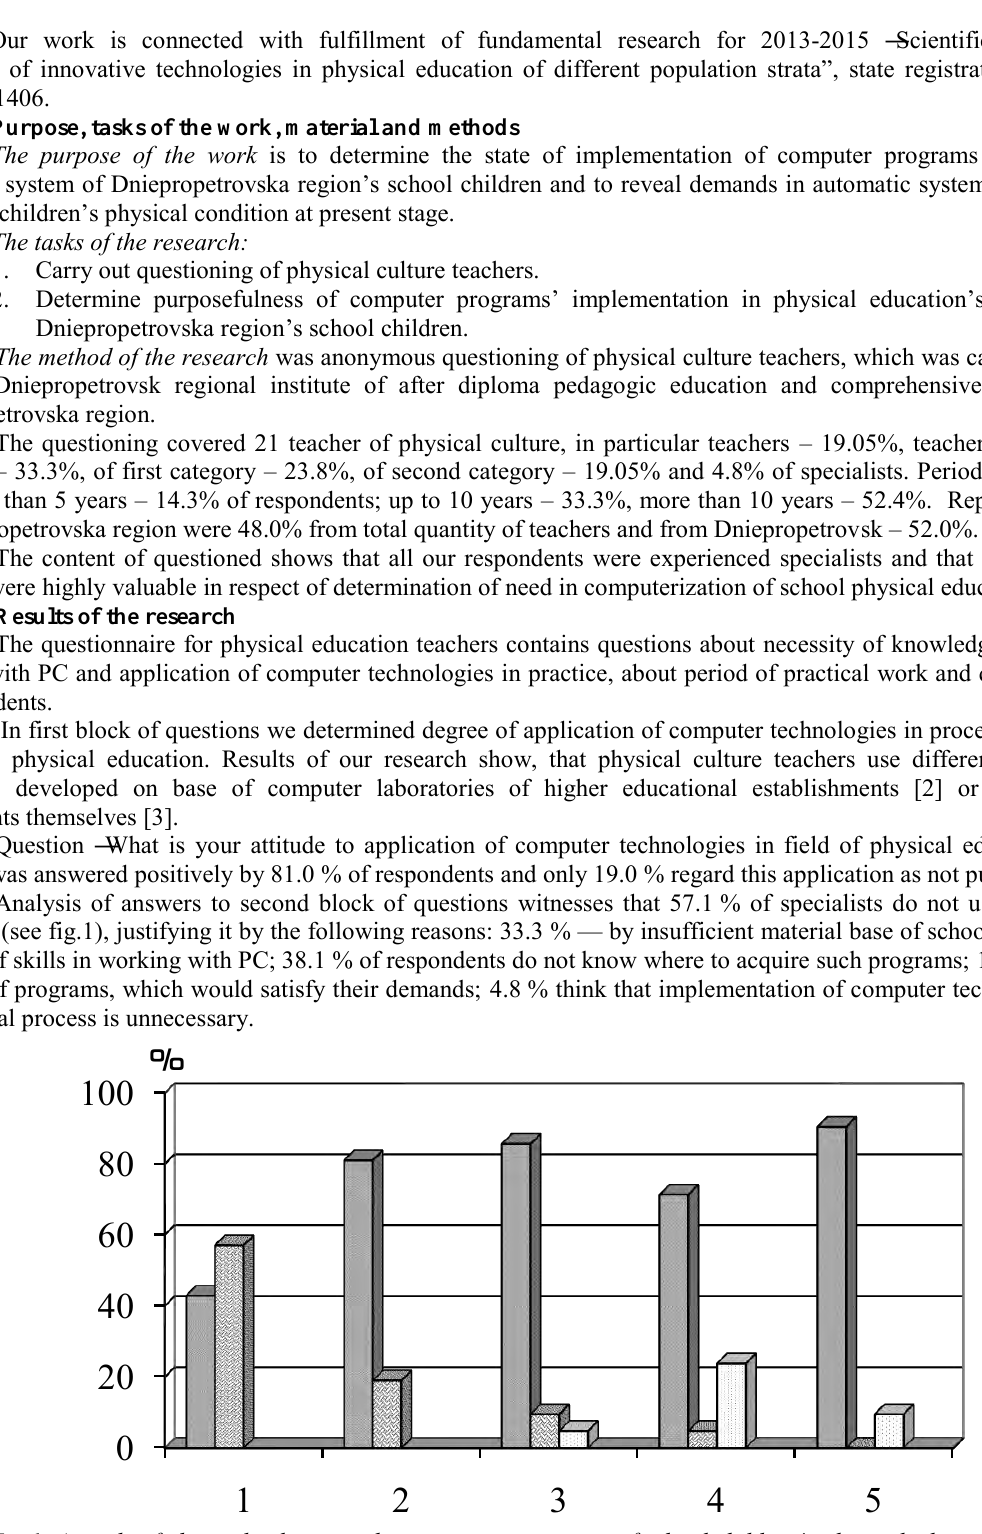
Fig.1. Attitude of physical culture teachers to computerization of school children’s physical